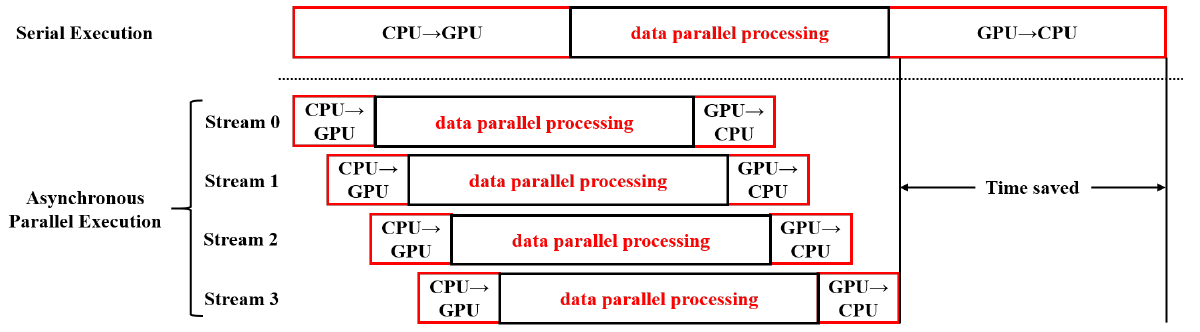
Figure 5. Asynchronous parallel execution and serial